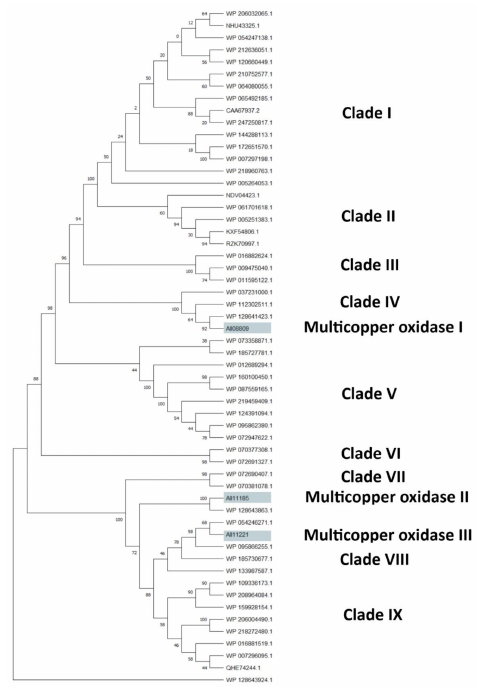
Figure 7. Subtree clusterization of HIT sequences identified by oxidase input genes putatively involved in C-C backbone plastic degradation. Marked boxes evidence the reference input